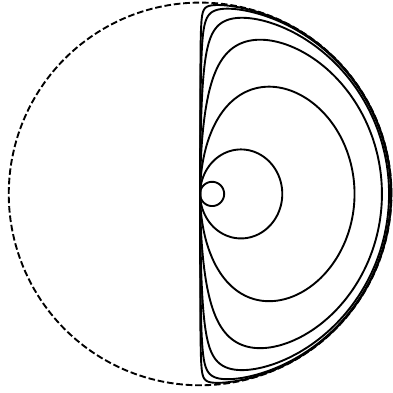
Figure 5: Sequence of causal diamond edges anchored at the origin and with growing radius, shown on a time slice of compactified 2 + 1 dimensional Minkowski spacetime. In the infinite radius limit, the entire Rindler horizon subtends an infinitesimal angle of the diamond’s edge, and the remainder of the edge lies at spatial